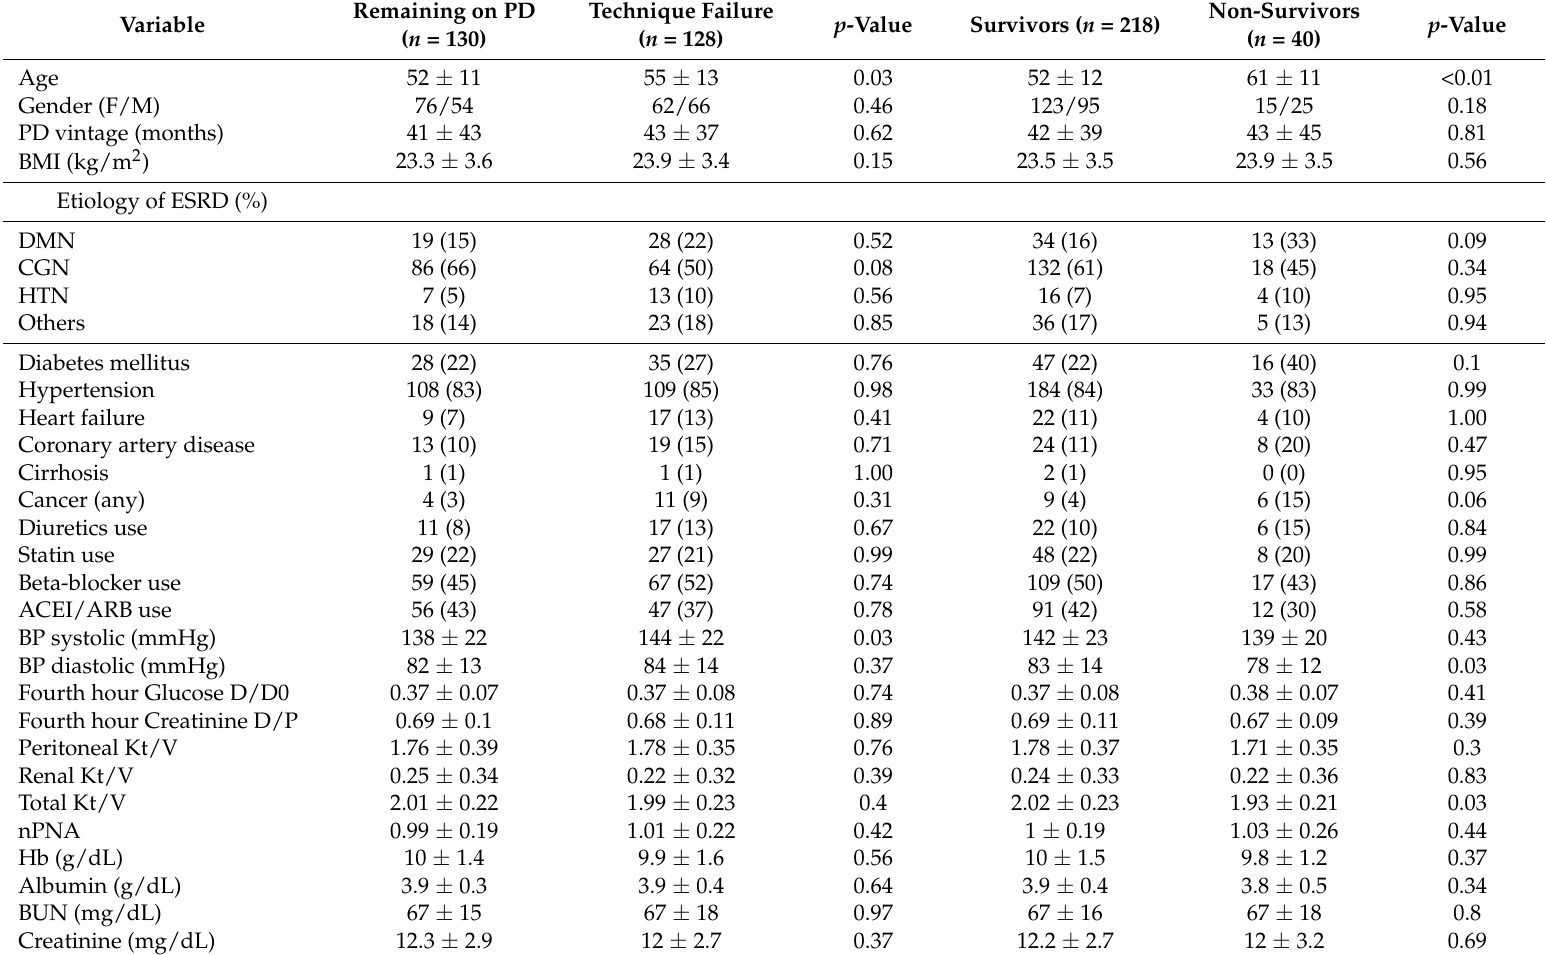
Table 3. Comparison of clinical characteristics between those with and without